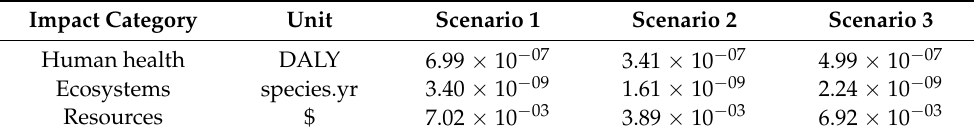
Table 5. Results of LCA for different scenarios of concrete mix